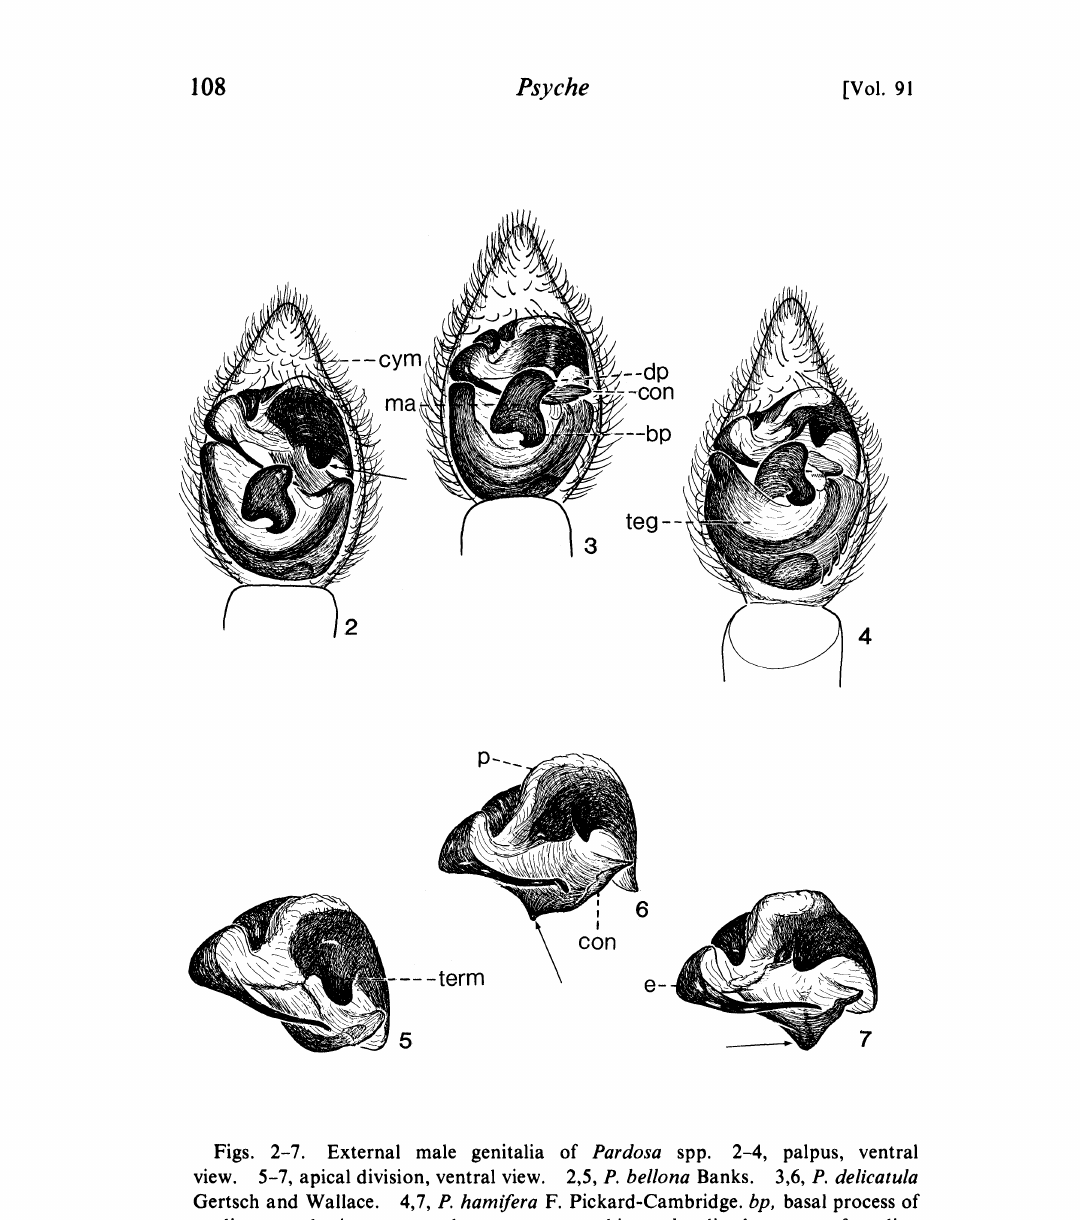
Figs. 2-7. External male genitalia of Pardosa spp. 2-4, palpus, ventral view. 5-7, apical division, ventral view. 2,5, P. bellona Banks. 3,6, P. delicatula Gertsch and Wallace. 4,7, P. hamifera F. Pickard-Cambridge. bp, basal process of median apophysis, con, conductor, cym, cymbium, dp, distal process of median apophysis, e, embolus, ma, median apophysis, p, palea, teg, tegulum, term, terminal